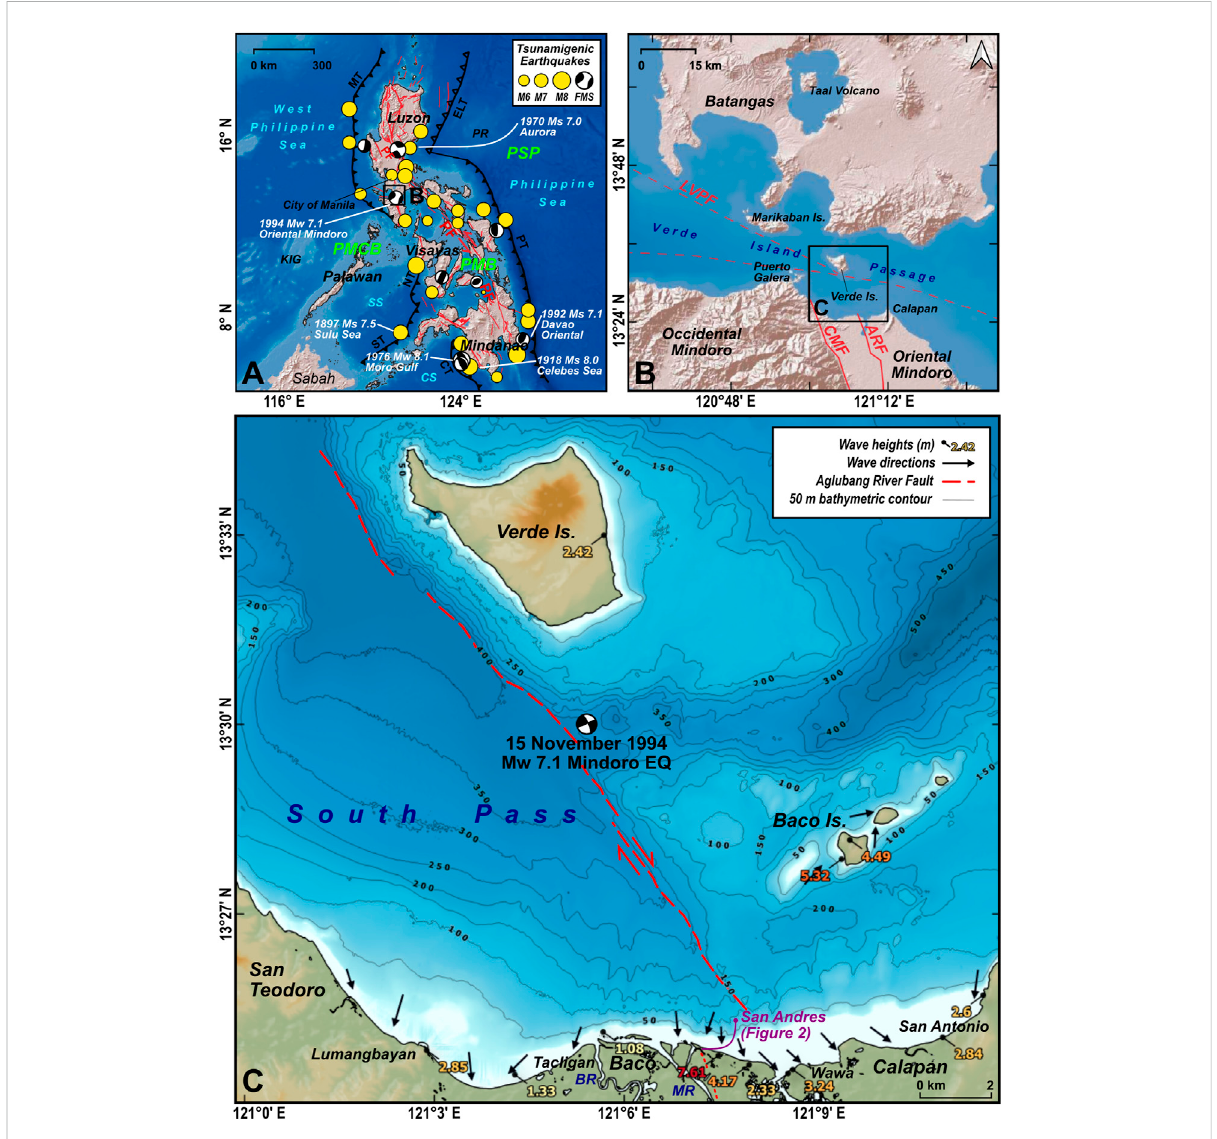
FIGURE 1 Philippine tectonic setting and notable tsunamis. (A) The 35 positive tsunamigenic earthquakes in the Philippines since 1589 AD with recorded or estimated wave heights at shore of at least 1 m (Bautista et al., 2012; NCEI/WDS, 2022) are plotted with yellow circles, or with the corresponding focal mechanism solution (FMS) diagrams. The most signi fi cant tsunamis, with maximum wave heights at shore exceeding 4 m, are also labeled. Oceanic trenches are also shown and labeled, including active faults in red (PHIVOLCS). (B) Location of the South Pass within the Verde Island Passage, where the 1994 Mindoro tsunami occurred. (C) Tsunami wave heights (modi fi ed from Imamura et al., 1995; see Supplementary Table S1) and directions of wave inundation (PHIVOLCS, 1994). The trace of the offshore extension of the Aglubang River Fault is also indicated, as mapped from the analysis of high-resolution bathymetry data in this study. FMS diagrams are from the Global Centroid Moment Tensor catalog (GCMT; Dziewonski et al., 1981; Ekstrom et al., 2012). PMB = Philippine Mobile Belt; PMCB = Palawan Microcontinental Block; PSP = Philippine Sea Plate; MT = Manila Trench; NT = Negros Trench; ST = Sulu Trench; CT = Cotabato Trench; ELT = East Luzon Trough; PT = Philippine Trench; PF = Philippine Fault; SS = Sulu Sea; CS = Celebes Sea; KIG = Kalayaan Island Group; PR = Philippine Rise; ARF = Aglubang River Fault; CMF = Central Mindoro Fault; LVPF = Lubang-Verde Passage Fault; BR = Baco River; MR = Malaylay